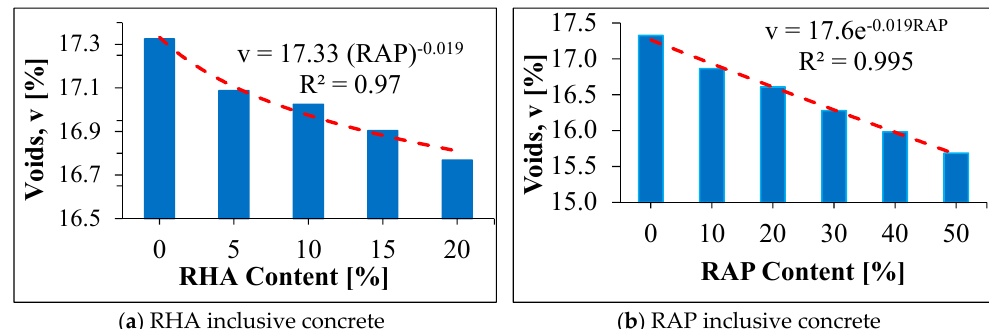
Figure 17 . Voids in RHA and RAP concrete.